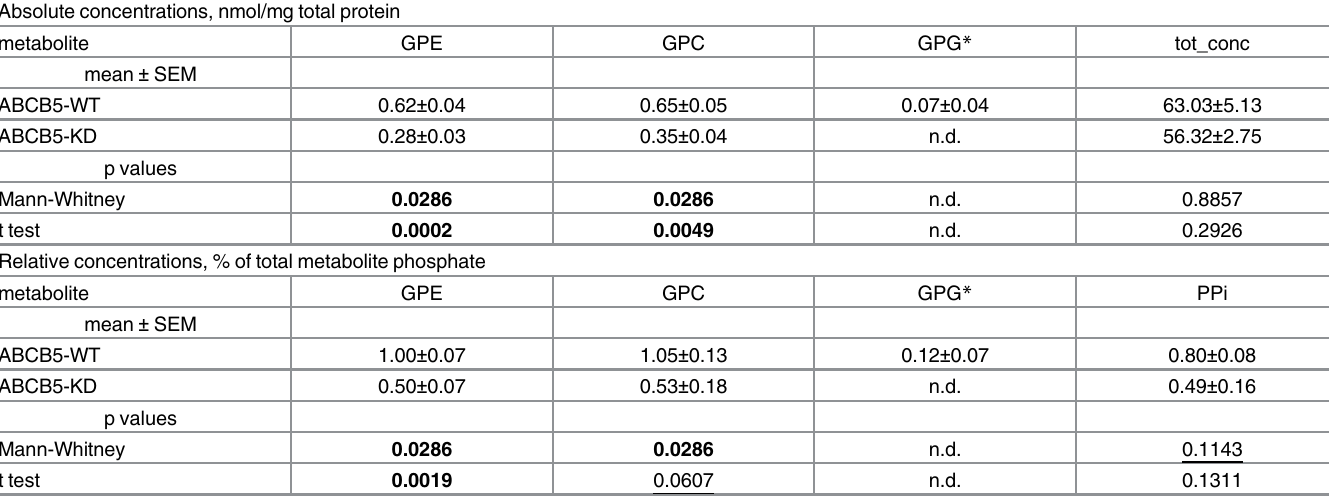
Table 2. Significant differences between levels of phosphorylated water-soluble metabolites in ABCB5-WT and ABCB5-KD G3361 melanoma cells based on 31 P NMR spectroscopy of cell